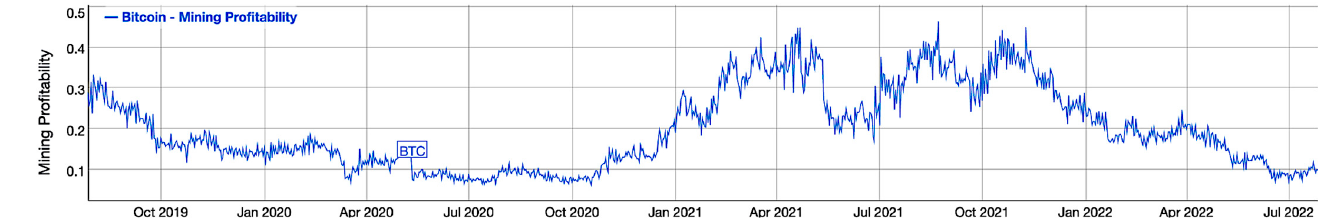
Figure 2. Bitcoin daily profitability (USD/Th/day) from the third quarter in 2019 to the present day [44].